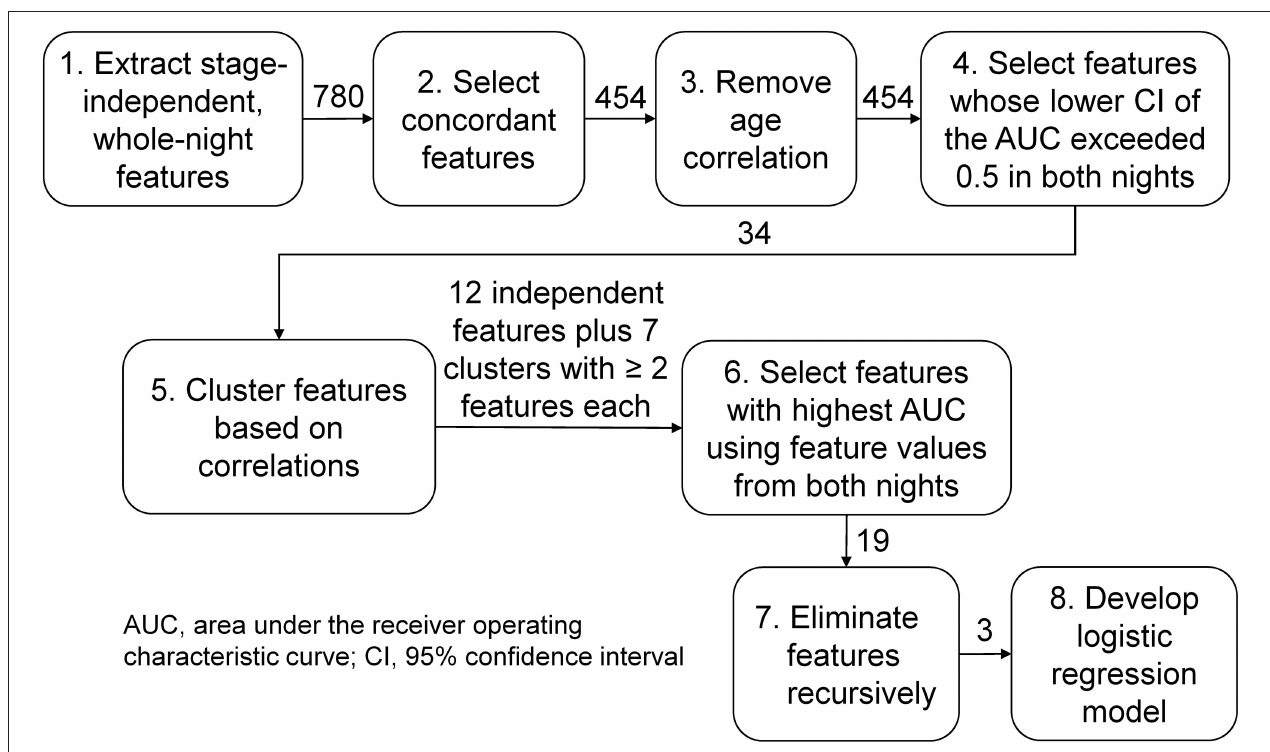
FIGURE 2 | Analysis workflow for feature selection and classifier development. We analyzed three types of sleep-stage independent features, (1) log powers, (2) their coefficients of variation, and (3) the phase synchrony between pairs of electroencephalography channels, averaged across the entire night, in twelve frequency bands of interest. We started with 780 features (120 type 1, 120 type 2, and 540 type 3) and ended up with three features, one of type 1 and two of type